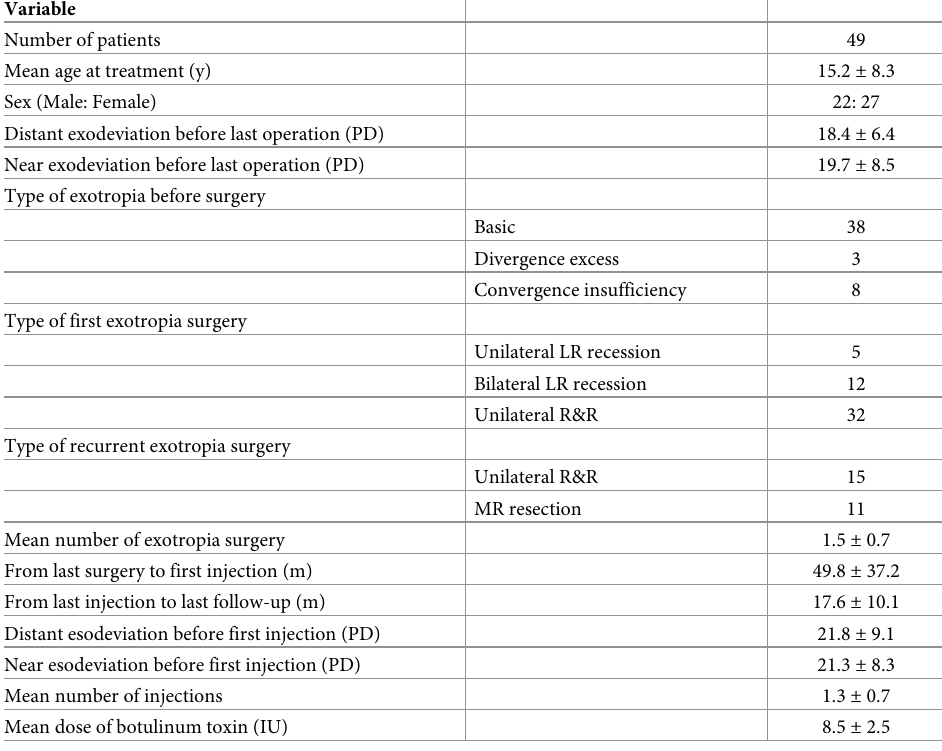
Table 1. Demographics and clinical characteristics of consecutive esotropia patients who underwent botulinum toxin injection without electromyographic